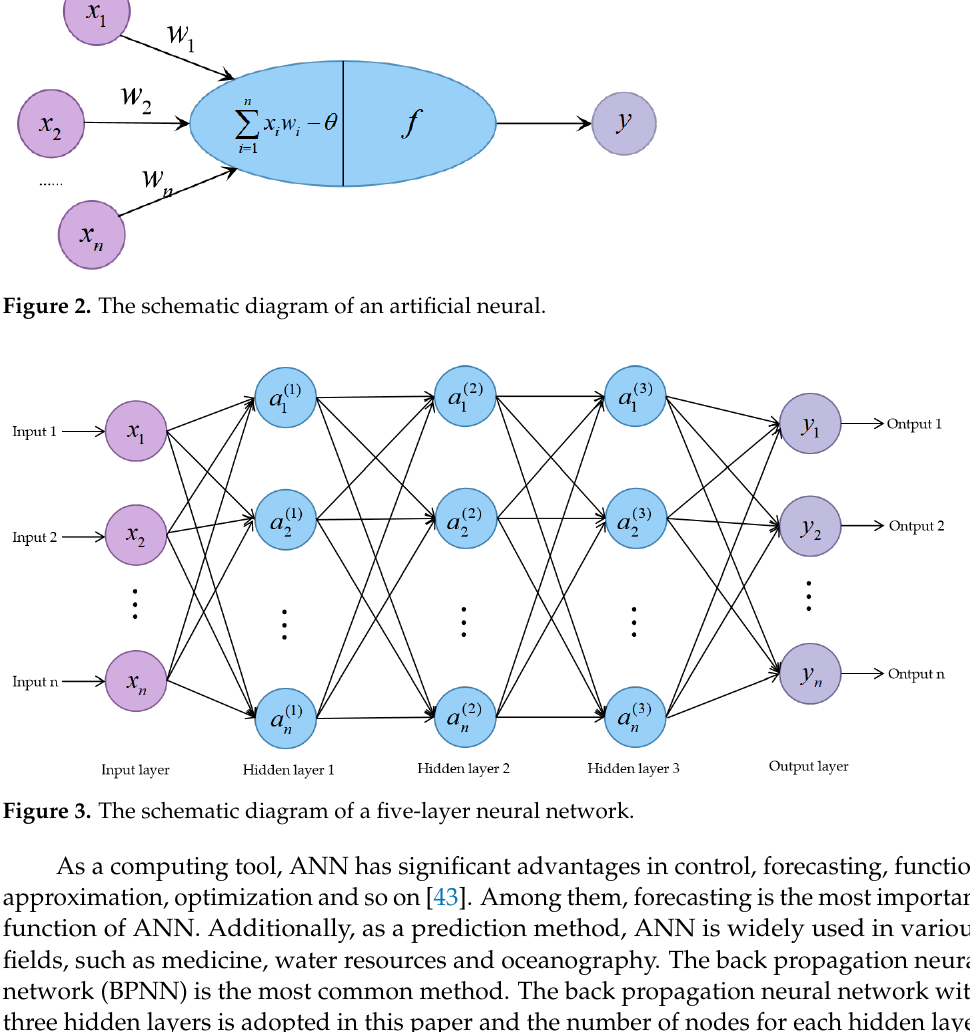
Figure 2. The schematic diagram of an artificial neural.